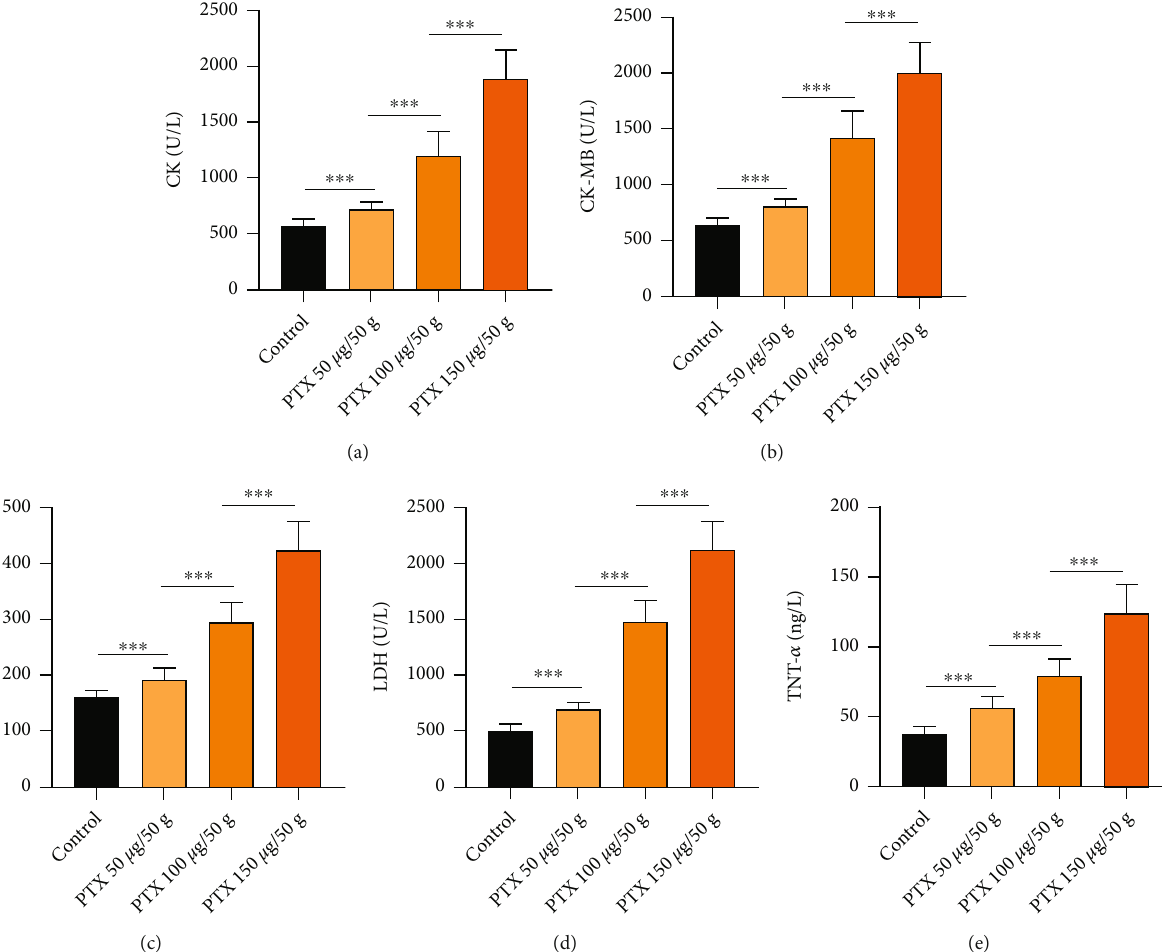
Figure 1: Changes of myocardial enzyme indexes and serum TNF- α in mice after paclitaxel (PTX) intervention. (a) Creatine phosphokinase (CK). (b) Muscle kinase isoenzyme (CK-MB). (c) Aspartate aminotransferase (AST). (d) Lactate dehydrogenase (LDH) level. (e) Tumor necrosis factor-alpha (TNF- α ). ∗∗∗ P < 0 : 0001